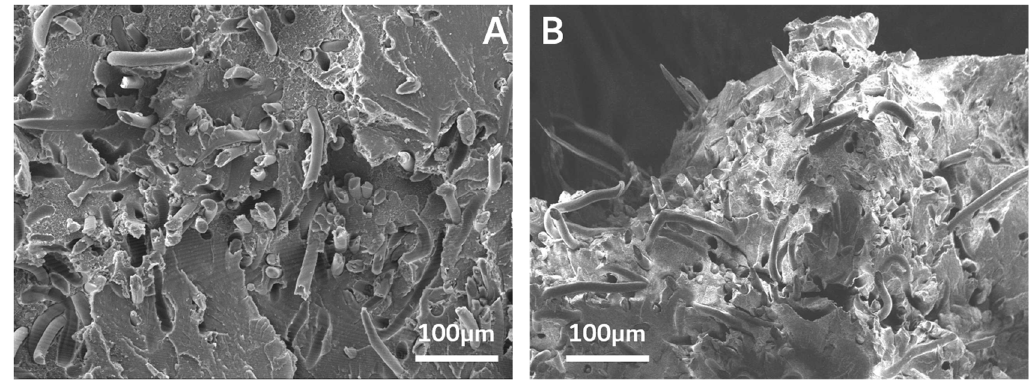
Figure 4. FE–SEM image of the breakage site of the PGA–PLA block copolymer composites for the PGA–b-PLA ( A ) and the b-PLLGA composites ( B ).